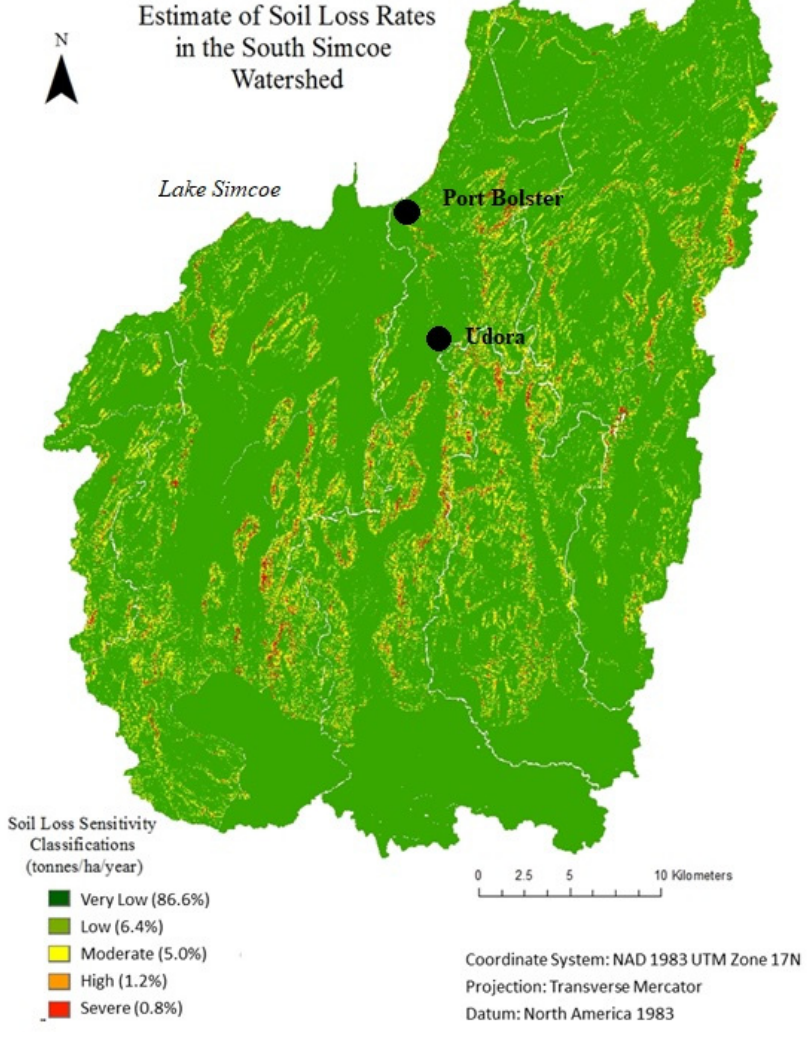
Figure 5. Areal extent of the average potential soil loss (t/ha/year) with the Universal Soil Loss Equation. Table 1. Percentage of the area by sub watershed and soil loss severity class.